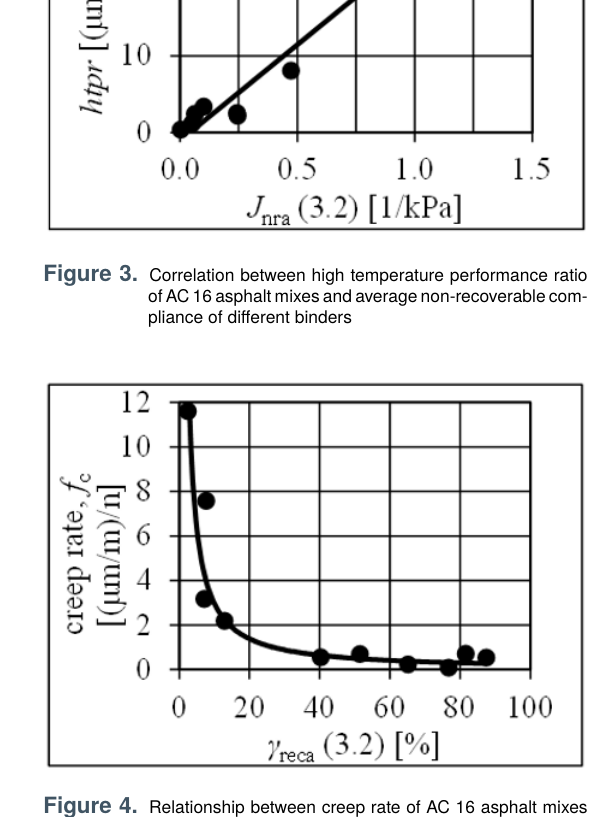
Section 1 as well as with finite-difference and moving av- erage methods. From data analysis it was revealed that with increasing bitumen penetration the creep parameters of asphalt concrete mix show larger variation. For hard paving bitumen the test stress level should be increased to obtain appropriate and comparable creep